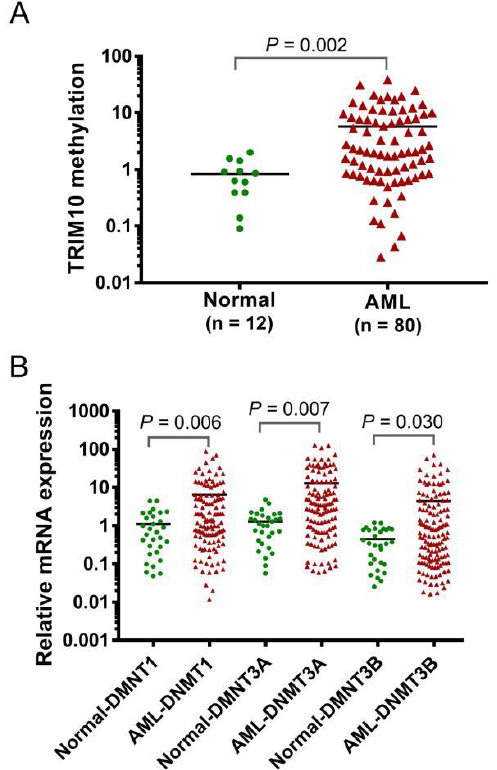
Figure 5. TRIM10 downregulation is correlated with DNA methylation in AML cells. ( A ) Real-time quantitative methylation-specific PCR (RQ-MSP) analysis of TRIM10 methylation in AML patients ( n = 80) and normal controls ( n = 12). ( B ) qRT-PCR analysis of DNMT1, DNMT3A and DNMT3B mRNA expression in AML patients ( n = 120) and normal controls ( n = 30).